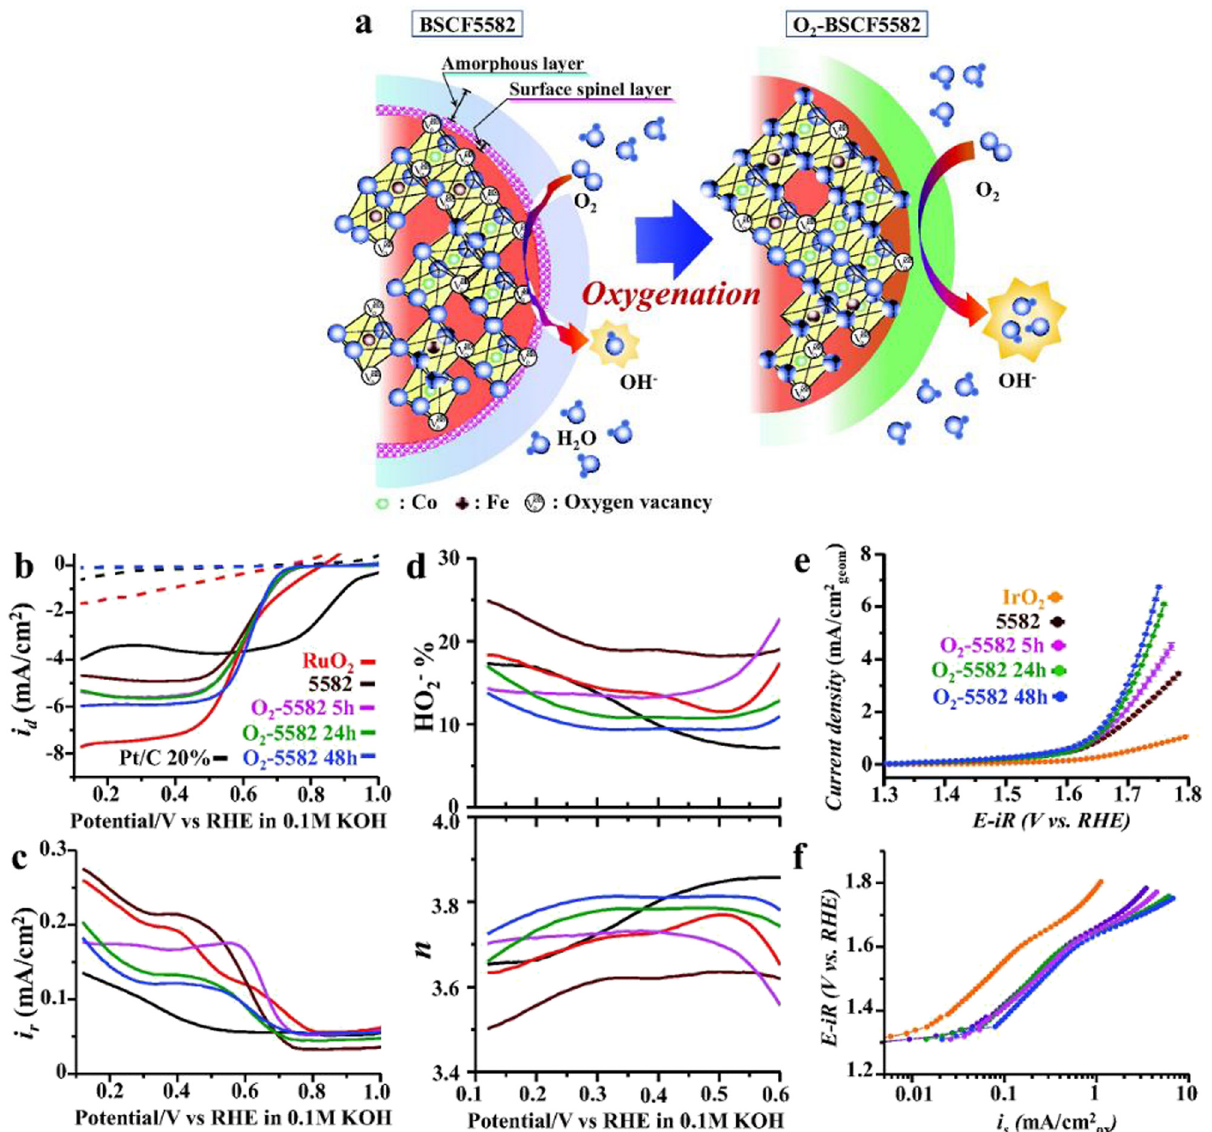
Figure 6: ( a ) Demonstration of the impact of heat analysis in oxygen on BSCF5582. ( b ) The ORR performances of BSCF5582 and O 2 - BSCF5582 in basic condition ( 0.1 M KOH ) under saturated oxygen gas ( solid lines ) and argon gas ( dotted lines ) . ( c ) Ring currents ( voltammograms ) of the ORR and the resolved ( d ) peroxide percentage ( HO 2 - % ) and electron - transfer number ( n ) applying rotating ring - disc electrodes ( RRDEs ) at 1600 rpm and a scan rate of 10 mV s − 1 in same conditions. ( e ) The OER performances of BSCF5582 and O 2 - BSCF5582 in same conditions. ( f ) Tafel plot of the OER - speci fi c performances of BSCF5582 and O - 2